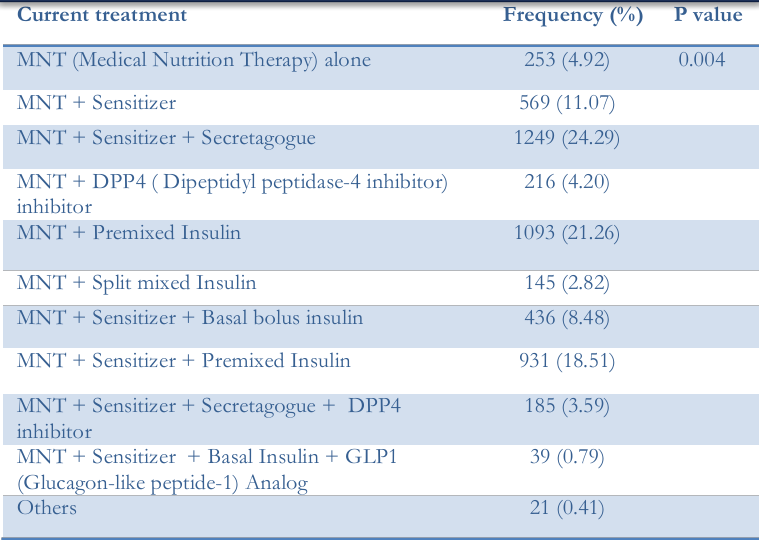
Table 3: Current modalities of treatment for diabetes (n=5140)